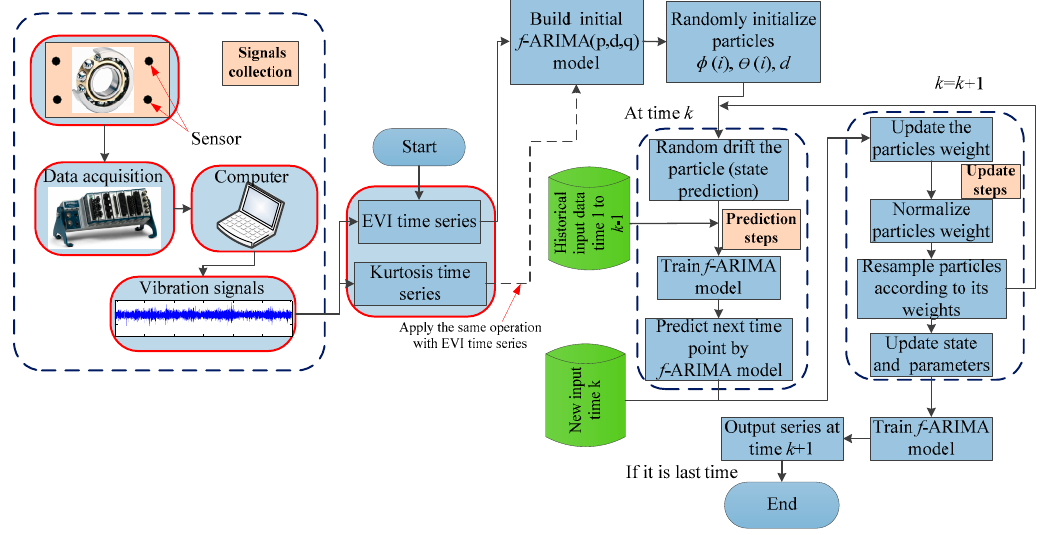
Figure 2. The flow chart of the proposed method for degeneration trend prognostics of rotating machinery.